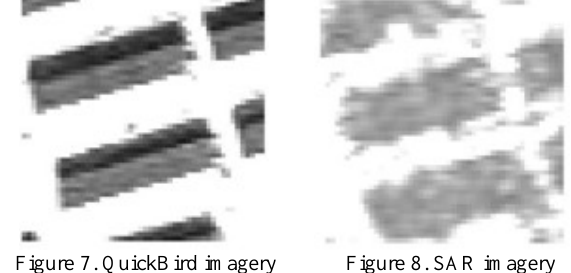
Figure 7. QuickBird imagery Figure 8. SAR imagery